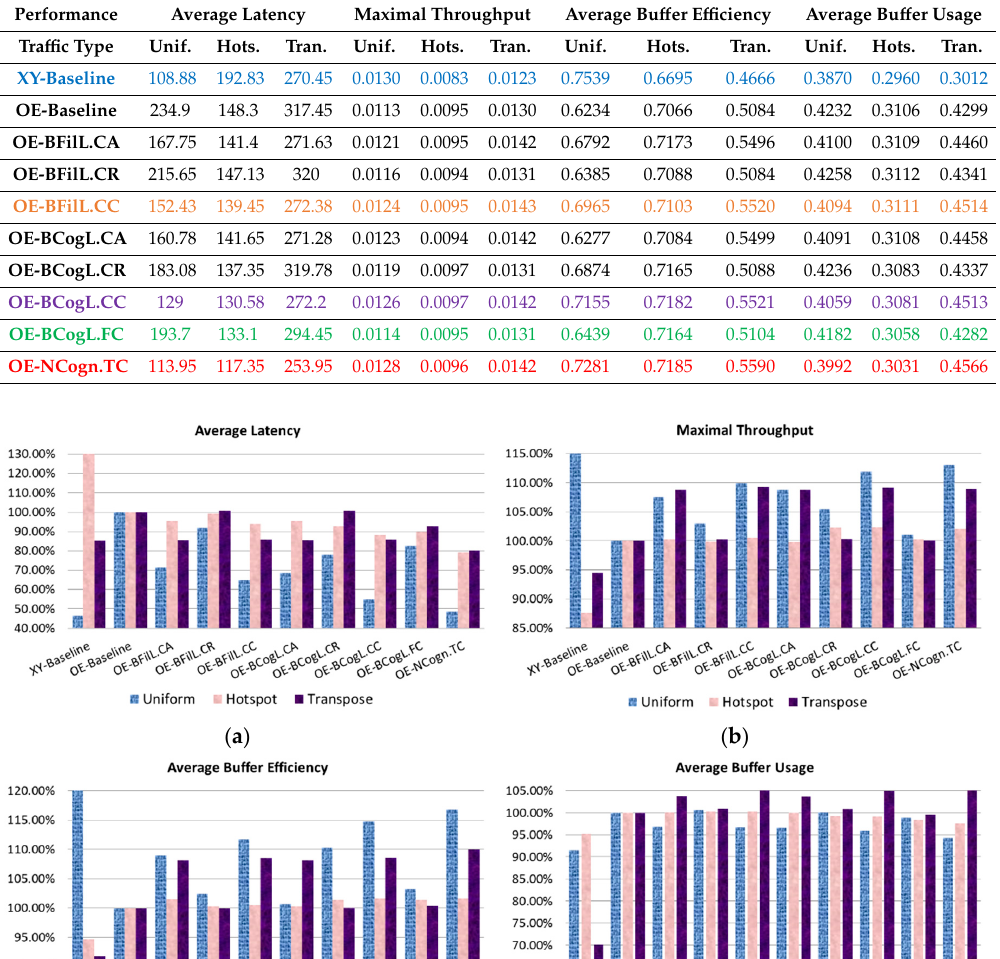
Table 4. Performance comparisons in average latency, maximal throughput, average bu ff er e ffi ciency, and average bu ff er usage among di ff erent control schemes and synthetic tra ffi c types.